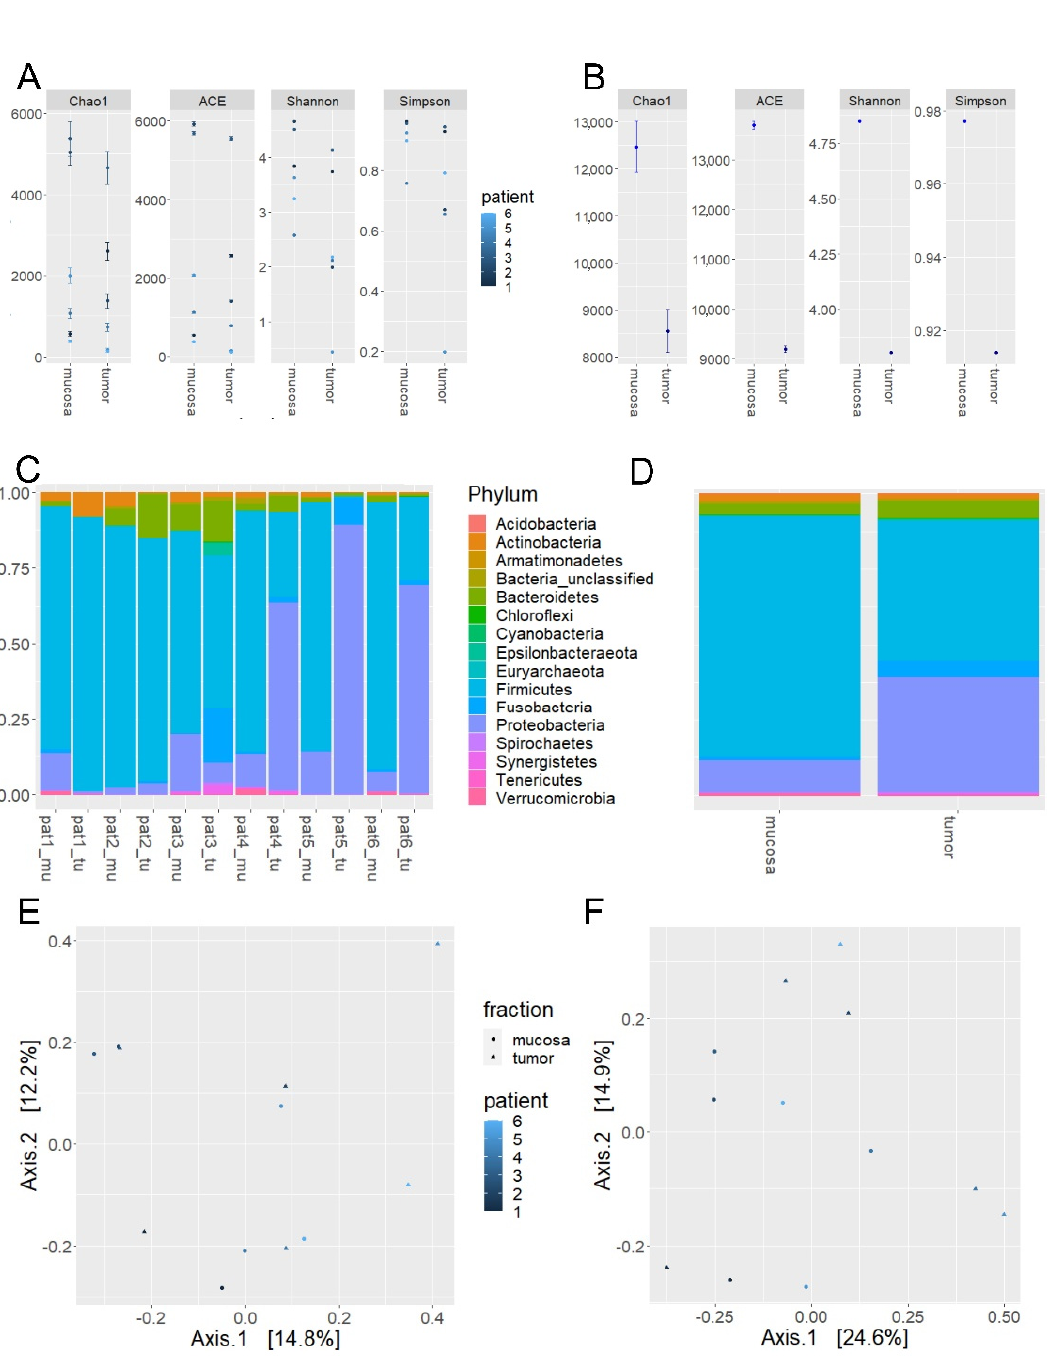
Figure 2. Alpha-diversity measures for all samples from ( A ) normal mucosa and tumor tissue as well as ( B ) between tumor and normal mucosa (mean) of step 2 experiments. Abundance on phylum level for ( C ) all individual patient samples [pat] and ( D ) the same samples grouped as tumor or mucosa tissue (number of reads normalized using median sequencing depth; tu = tumor sample; mu = mucosa sample). Principal coordinate analysis based on weighted ( E ) and un-weighted ( F ) UniFrac distances for mucosa and tumor samples.